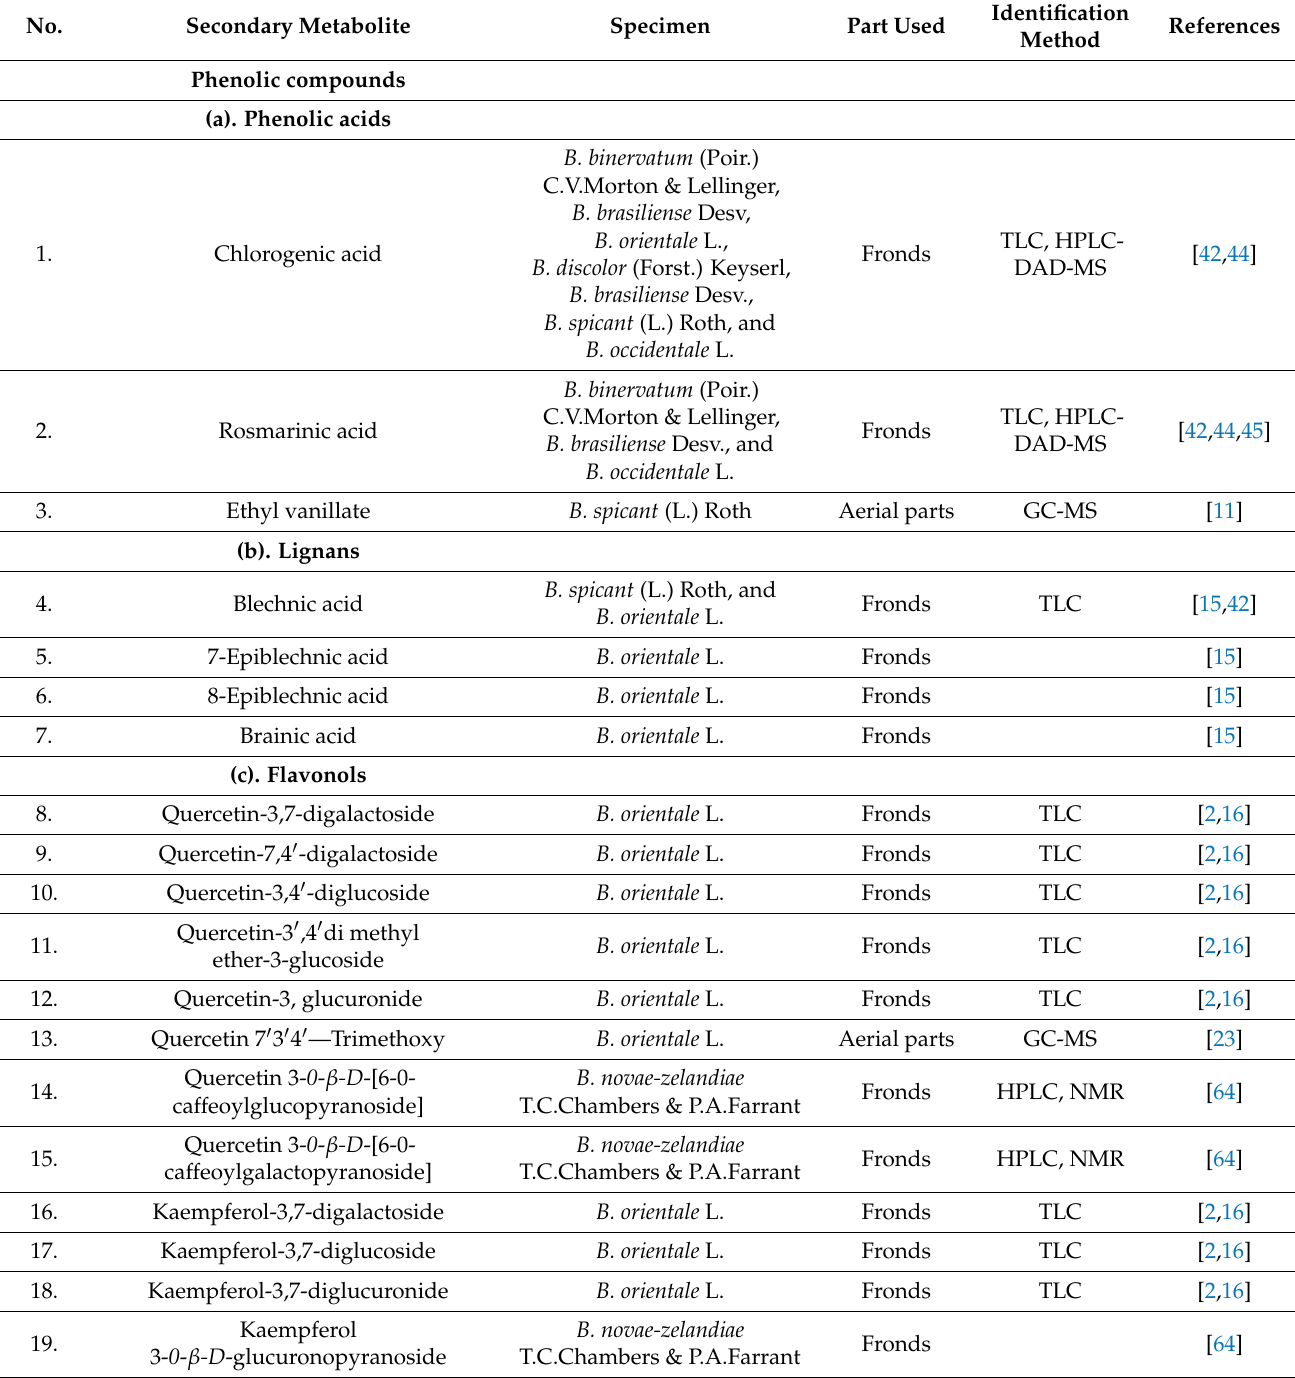
Table 2. Screened secondary metabolites from the Blechnum